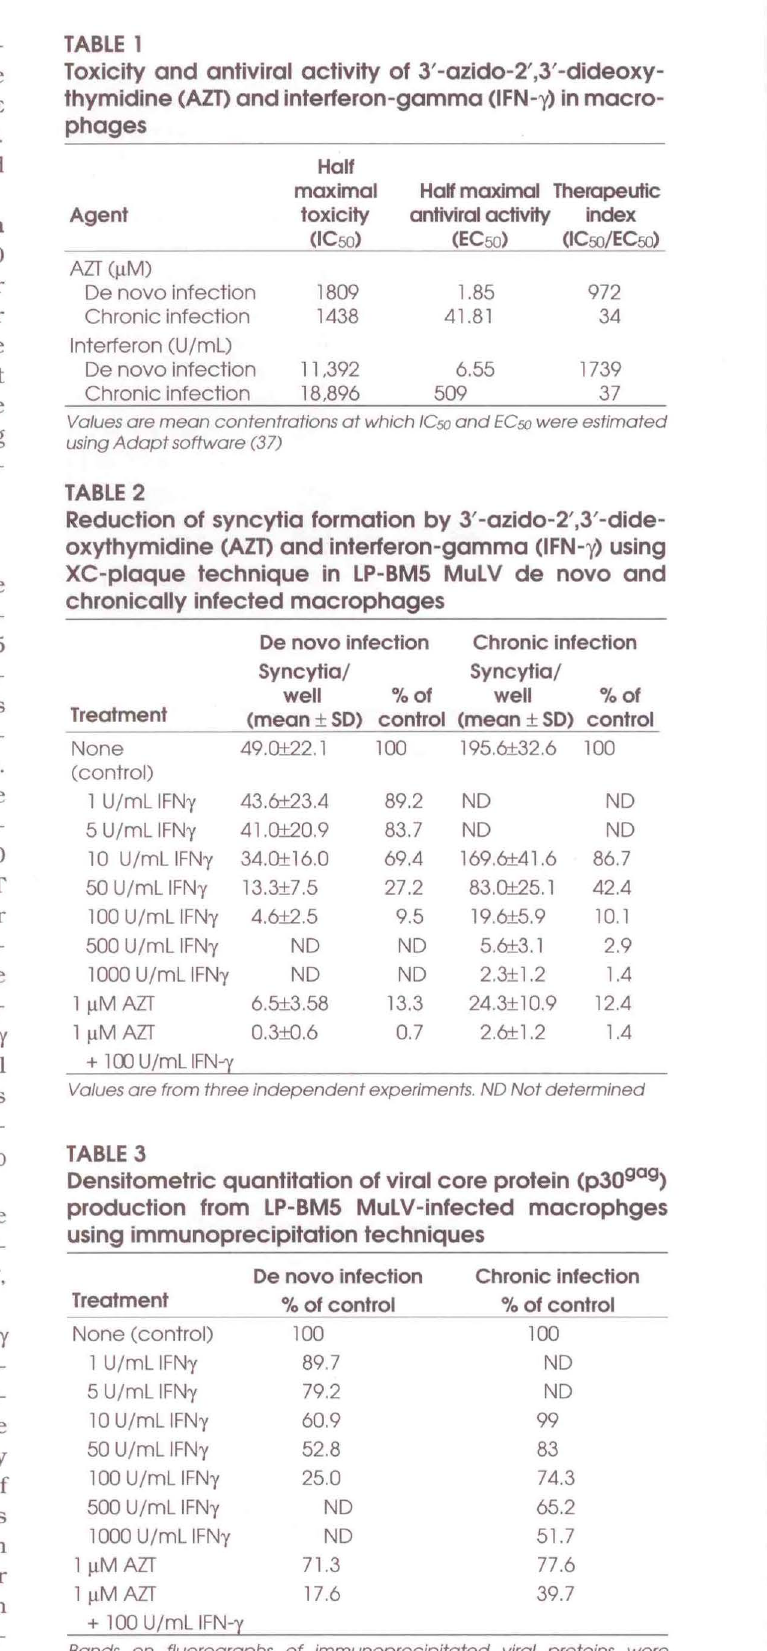
Densitometric quantitation of viral core protein (p30gag) production from LP-BMS MuLV-infected